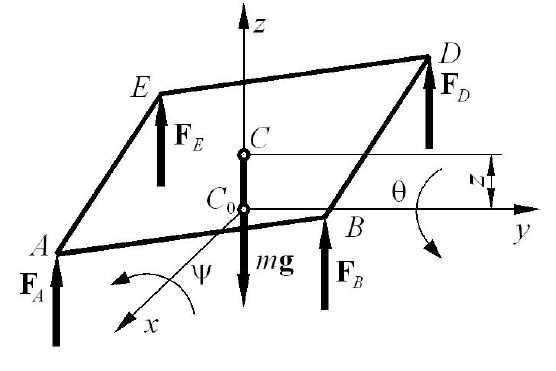
The equations (3) and (4) hold true if and only if the forces F A , F B , F C and F D are vertical ascendent. If the sense of one or more of these forces is vertical descendent the equations must be modified correspondingly. The problem appears because the expressions of the elastic forces in the springs are quadratic and they are not odd, that is the origin is not a point of